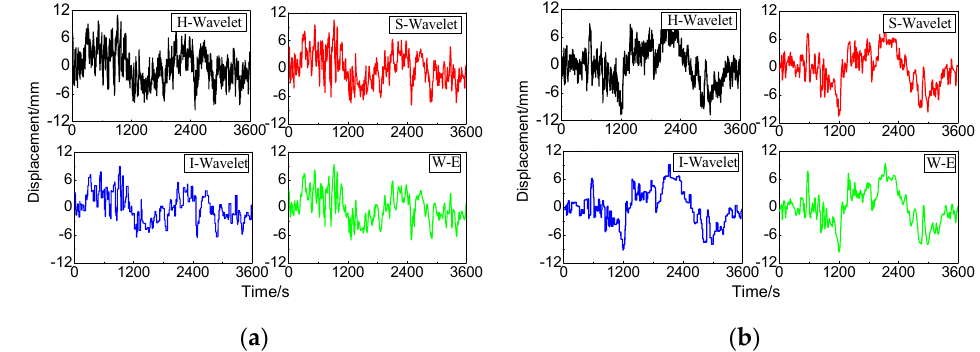
Figure 9. Comparison of denoising results from four methods in the time domain: ( a ) horizontal direction and ( b ) vertical direction. H-Wavelet represents hard threshold denoising, S-Wavelet represents soft threshold denoising, I-Wavelet represents half threshold denoising, and WE represents wavelet-EMD denoising